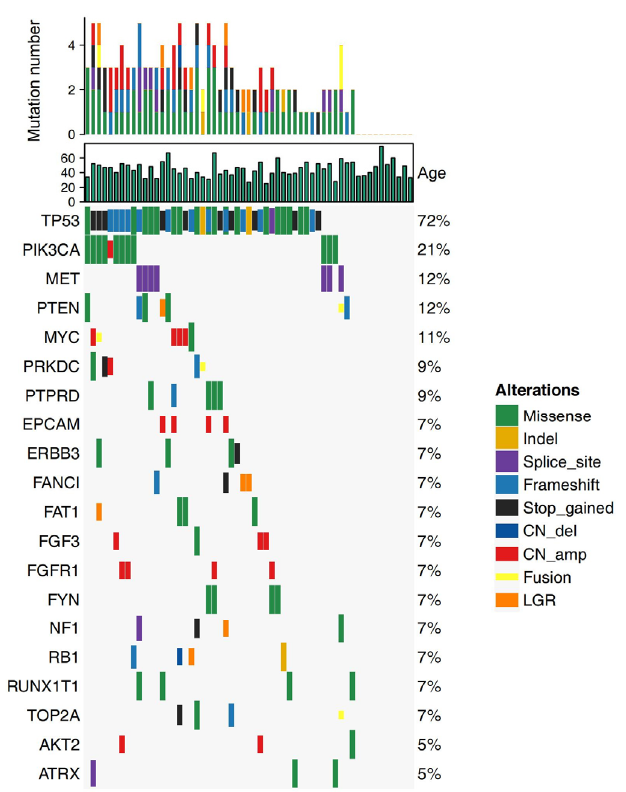
Figure 2. Alteration profiles of the top 20 genes from 57 patients with non-pCR TNBC. pCR, patho- logic complete response; TNBC, triple-negative breast cancer.